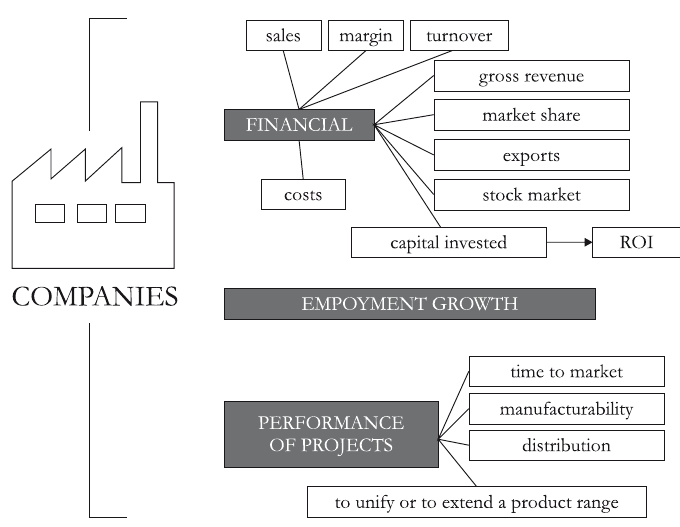
Fig. 2 – The selected dimensions and variables of the value which can be related to design according to the reported studies (Braga,